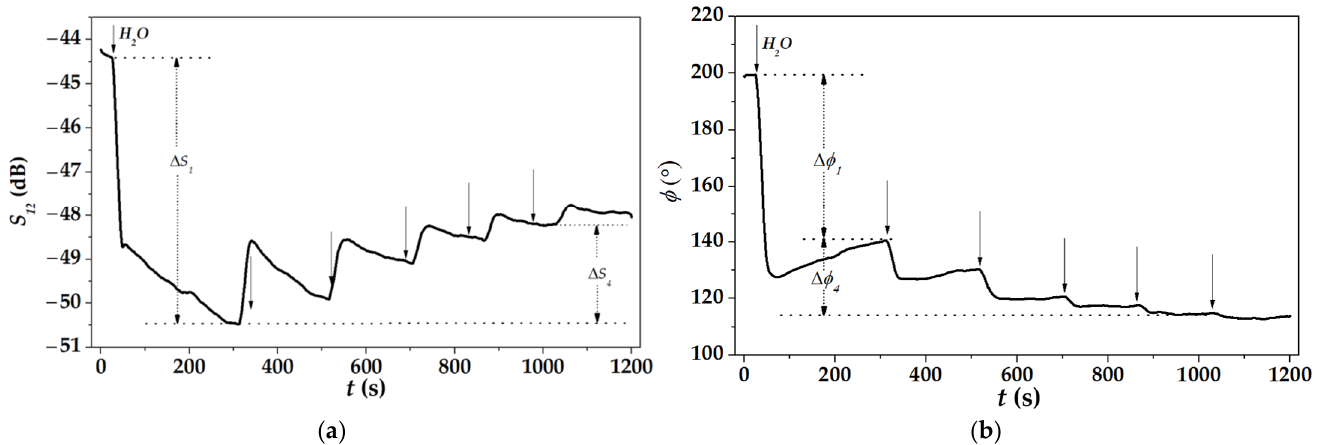
Figure 9. Time variations in the insertion loss S 12 (mode amplitude) ( a ) and the phase ϕ (mode velocity) ( b ) versus step-by-step increase in liquid conductivity σ (vertical arrows). Plate: 128°YX- LiNbO 3 , h = 350 μm, λ = 200 μm. Mode: f = 34.9 MHz, propagation direction Θ = 30° off X axis. Reference liquid: distilled water (200 mg, t < 0 s). Test liquid: distilled water (200 mg) with drops of 0.9% NaCl + H 2 O , 40 mg each (vertical arrows, 0 < t < 1200 Table 3. Acoustic plate modes with enhanced sensitivity towards liquid conductivity measured for different plates and propagation directions.